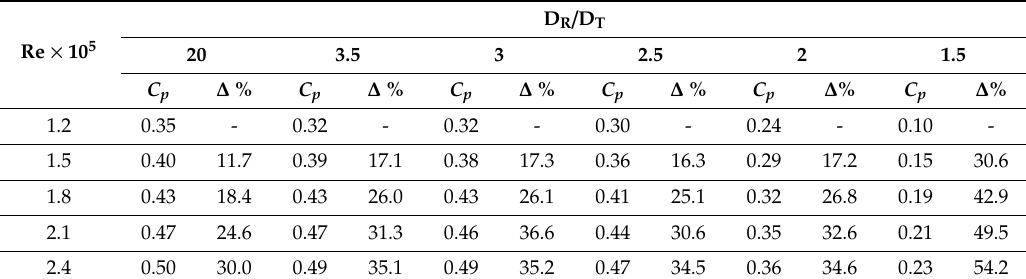
Table 1. Di ff erence in C p at various